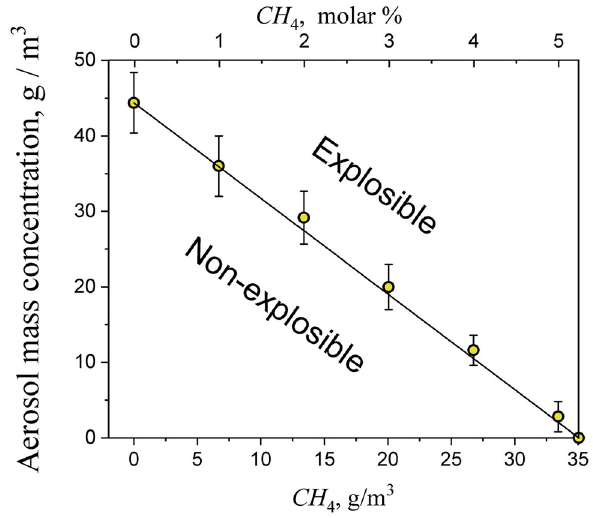
Fig. 15 Lower explosive limit for the mixture of aerosol and methane in air. Solid line follows Eq.